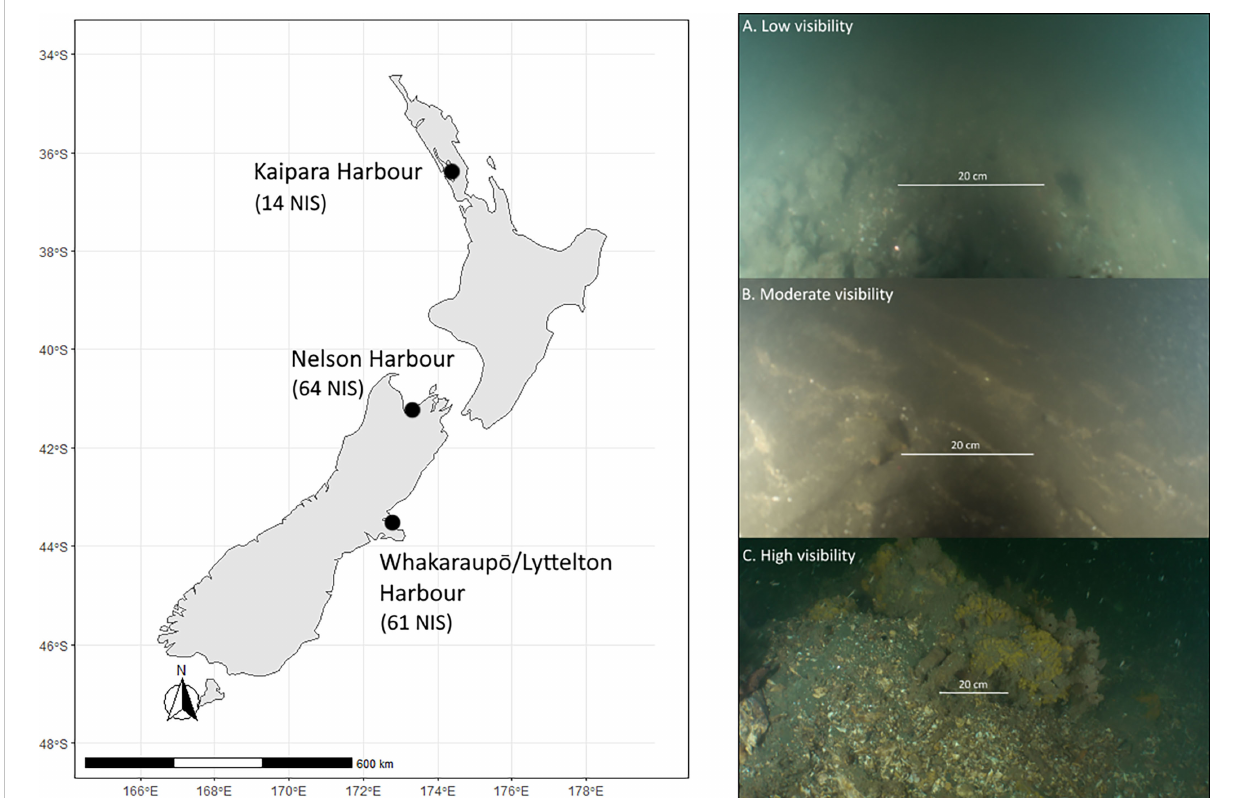
FIGURE 1 Study locations across Aotearoa New Zealand: Kaipara Harbour; Nelson Harbour; and Whakaraupo ̄ /Lyttelton Harbour. The number of con fi rmed NIS at each location are shown in brackets below the site label. The right-hand panel shows representative images of the sea fl oor across a gradient of water clarity in Kaipara Harbour and the decreasing swath width of sea fl oor visible with increasing turbidity. ( A , low visibility; B , moderate visibility; and C , high